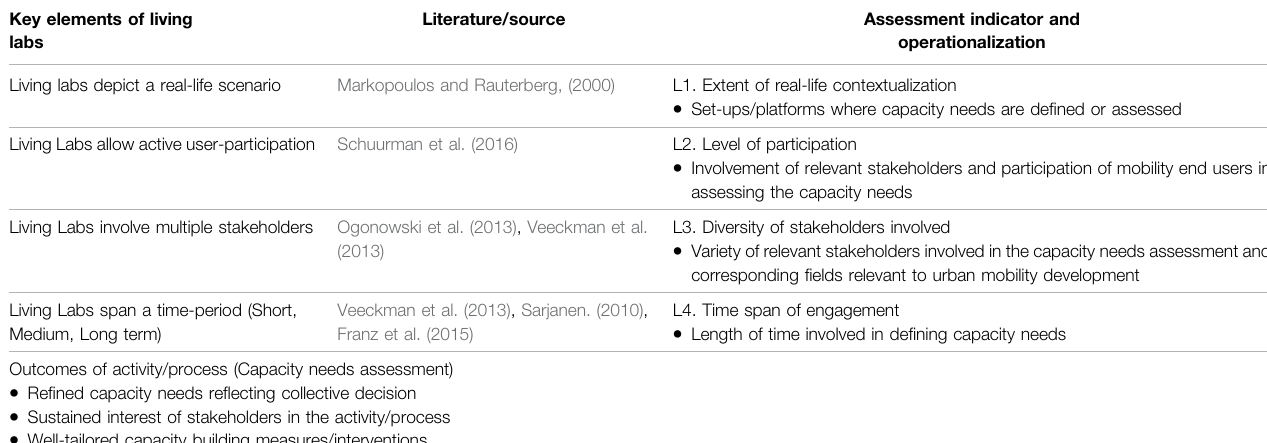
TABLE 1 | Assessment framework.